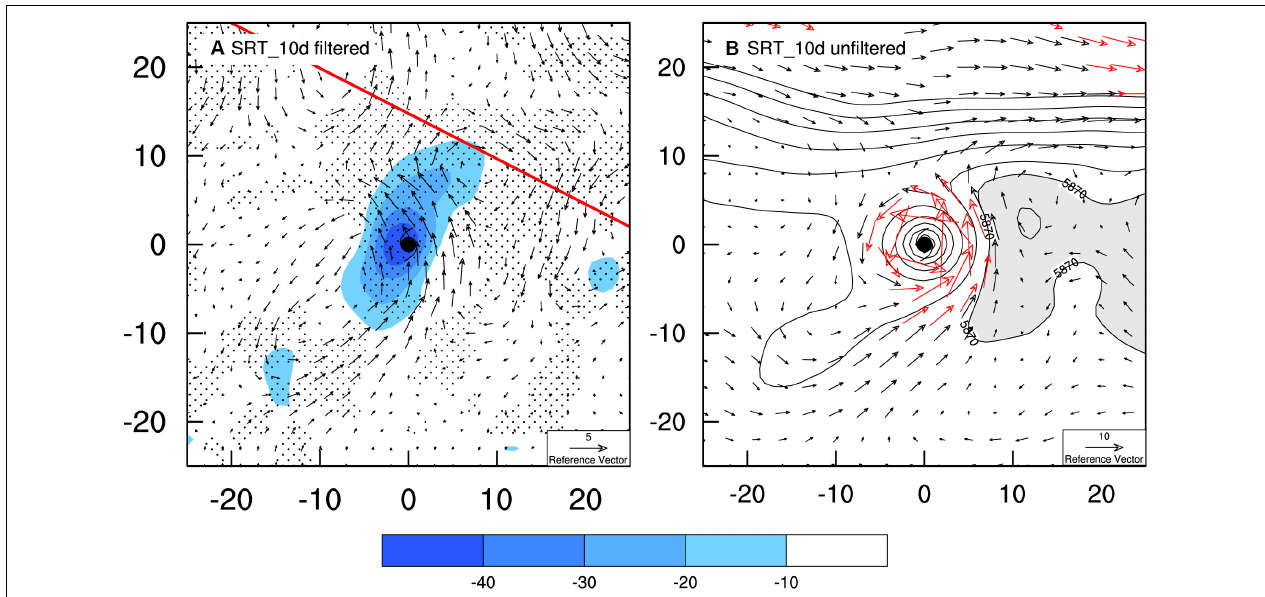
FIGURE 7 | (A) The composite filtered deep-layer averaged winds (vector, m s − 1 ) with the dotted area exceeding 95% significance, overlaid by the corresponding OLR field (shaded, W m − 2 ) and (B) Unfiltered 700-hPa winds (vector, m s − 1 ), and 500-hPa geopotential height (contour, gpm) for the R10 cases at the turning time. Red line denotes the orientation of synoptic-scale wave train. Red vectors in (B) represent wind speeds larger than 8 m s − 1 and areas more than 5870 (gpm) in (B) are shaded. The coordinates are the latitudes and longitudes based on TC